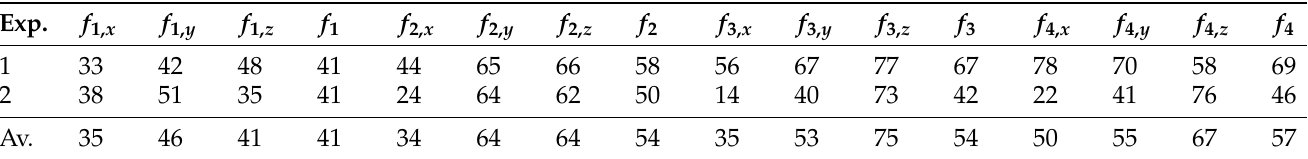
Table 11. ET frequency reduction rates during the Prototype (B) Closed-Loop evaluation. Exp.